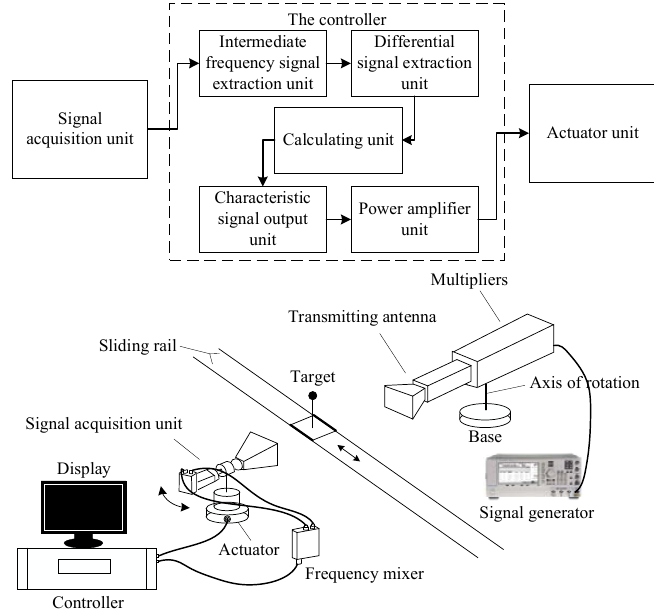
Figure 4. The composition of radar prototype.